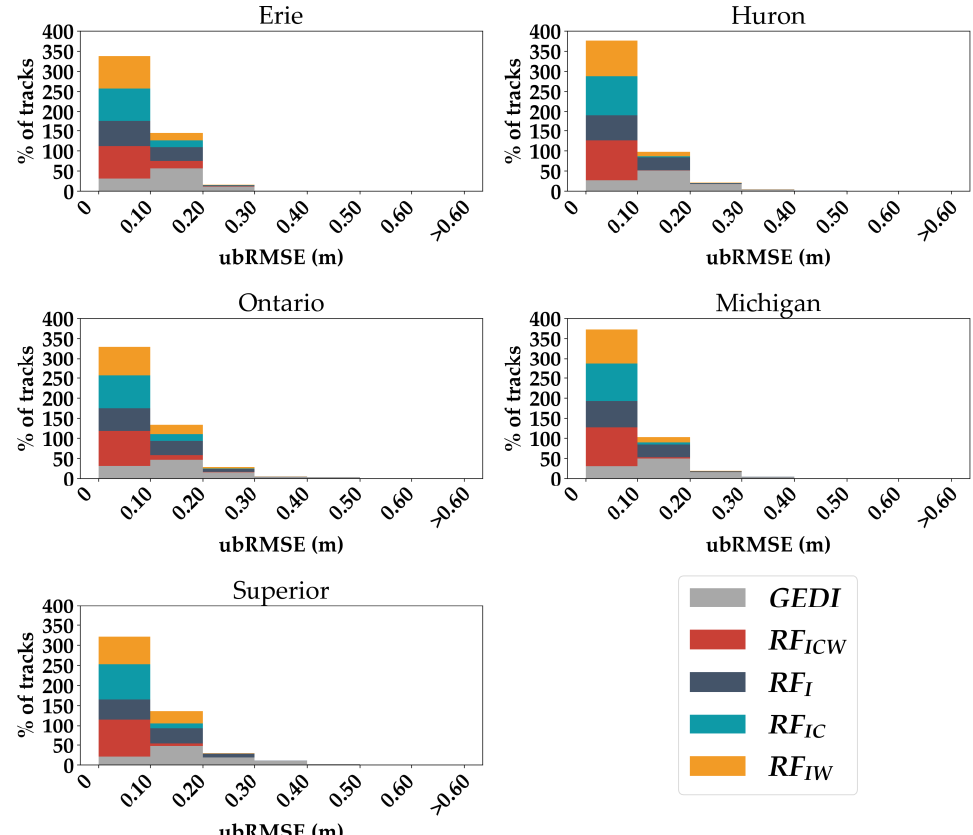
Figure 11. Stacked histograms of the distribution of the mean difference (bias) between GEDI (resp. 𝑅𝐹 𝑅𝐹 𝑅𝐹 𝑅𝐹 𝐼𝐶𝑊 , 𝐼 , 𝐼𝐶 , and 𝐼𝑊 ) and in situ elevations across the five studied lakes. Biases correspond to the mean difference calculated for GEDI shots grouped by acquisition date and the acquiring beam.